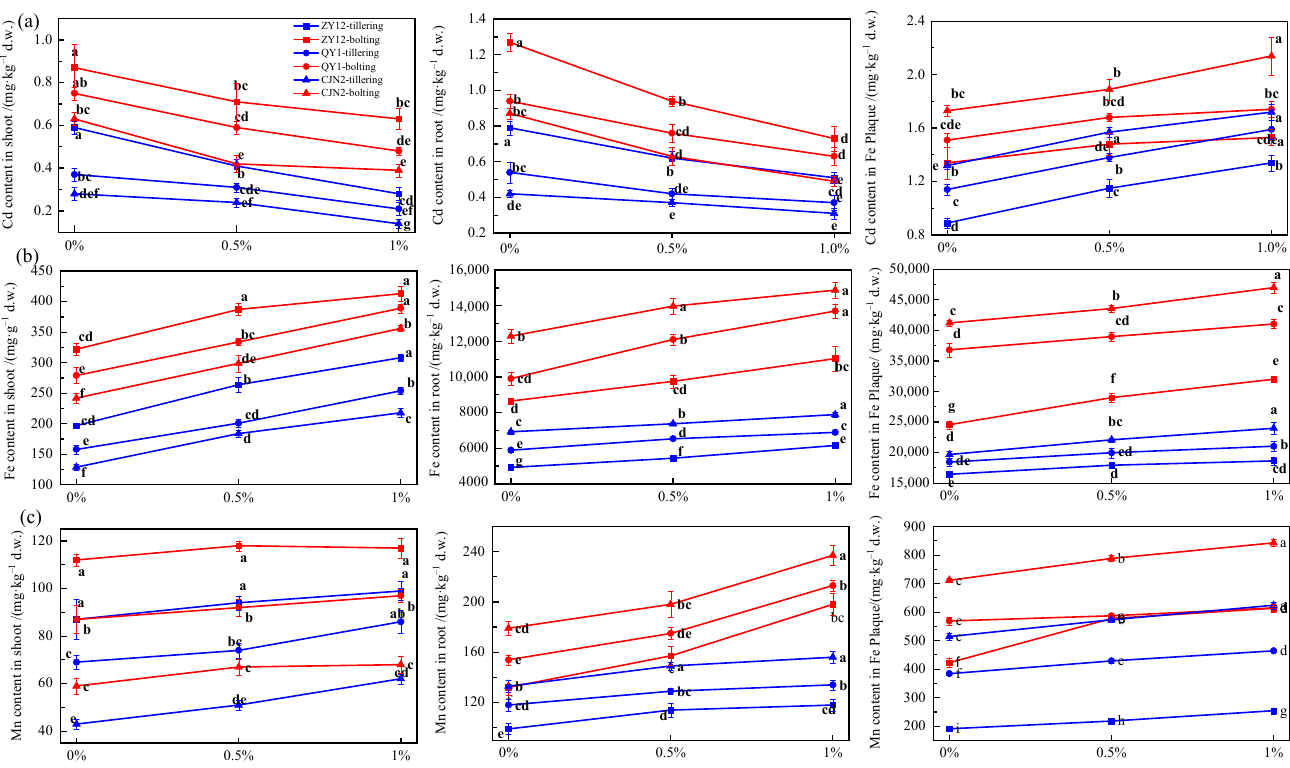
Figure 3. Effect of red mud (RM) on metals’ concentrations in the shoots, roots, and Fe plaque. ( a ) cadmium (Cd) concentration in rice tissues; ( b ) iron (Fe) concentration in rice tissues; ( c ) manganese (Mn) concentration in rice tissues. Different lowercase letters indicate a significant difference among treatments ( p < 0.05).